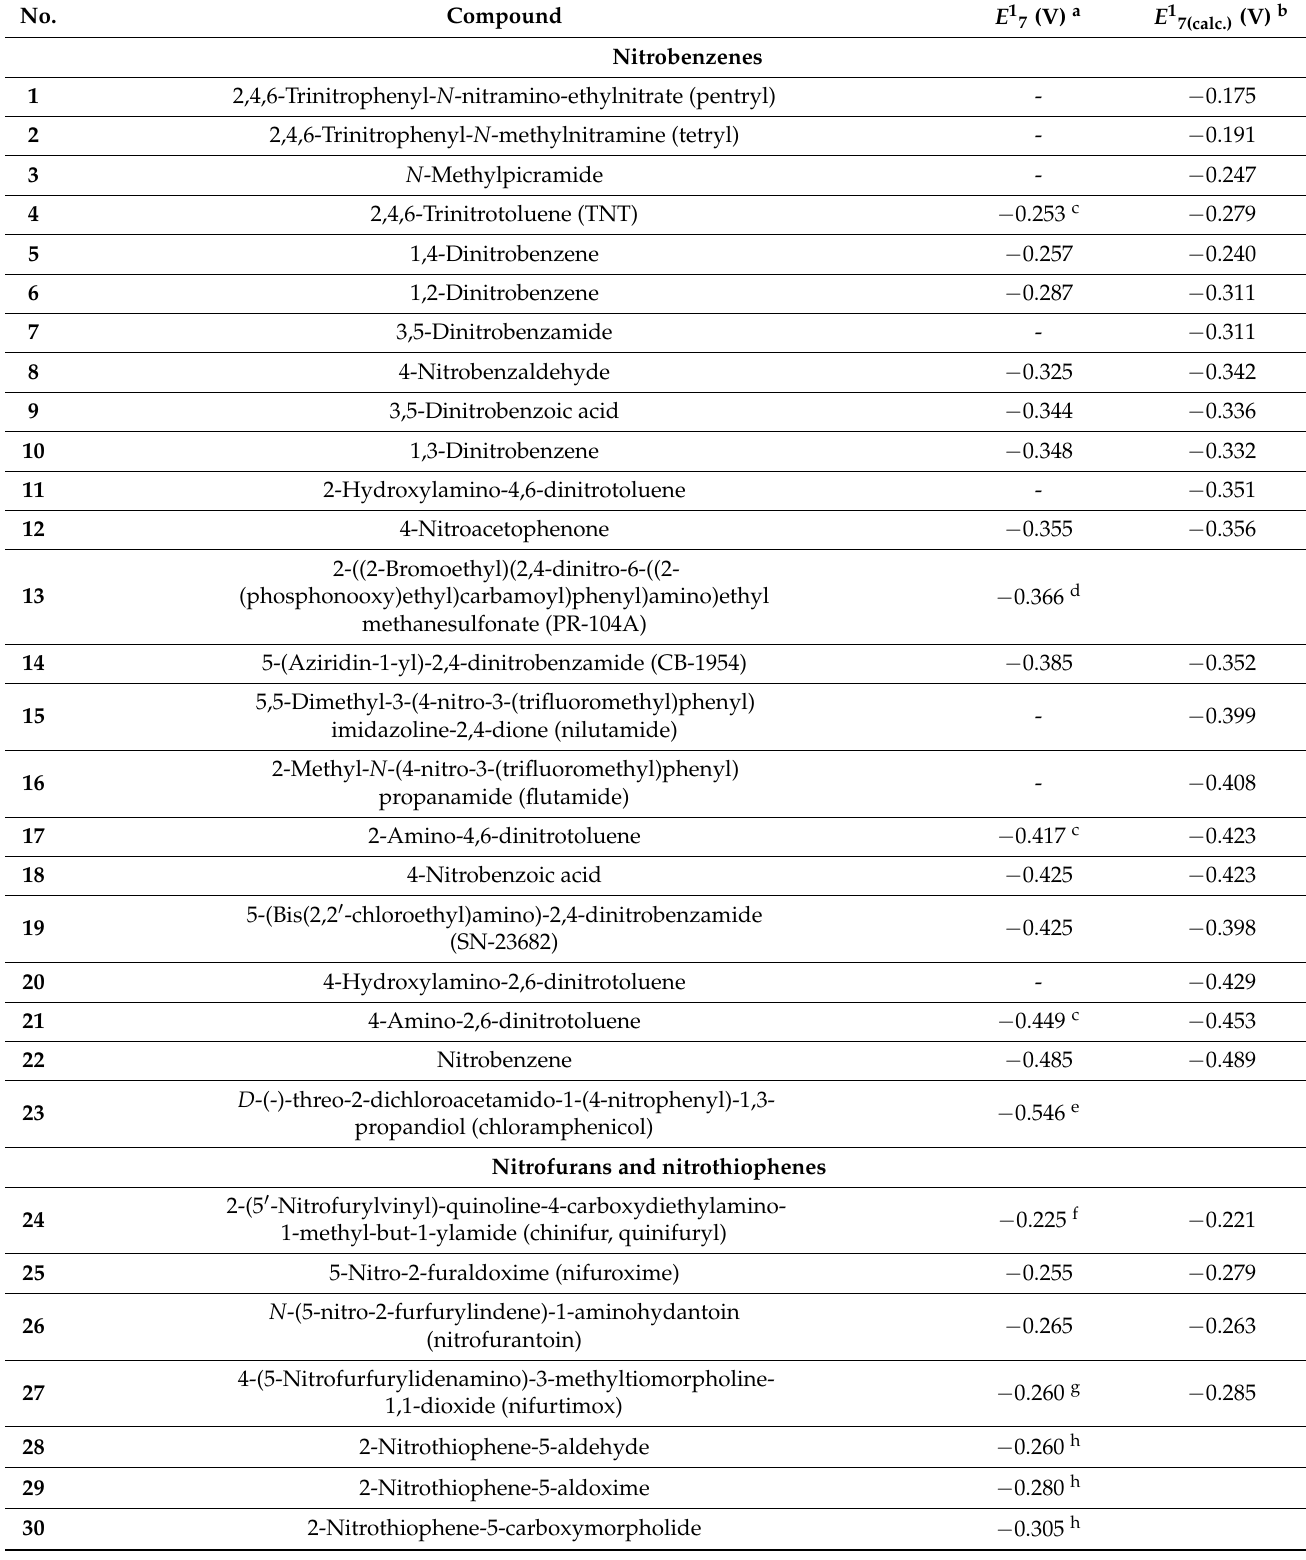
Table A1. Single-electron reduction midpoint potentials of nitroaromatic compounds determined by pulse radiolysis ( E 1 7 ) or calculated according to the data of enzymatic single-electron reduction ( E 1 7(calc.)